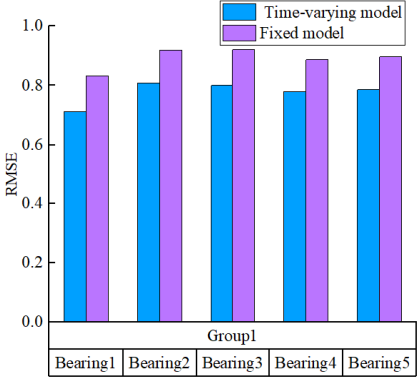
Figure 6. Comparison of RMSE predicted by two models.